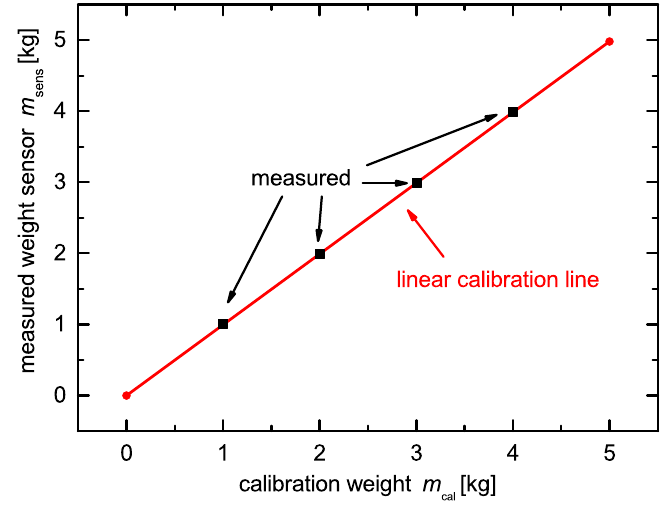
Figure 2. Linear calibration line of the load cell and measured weights using the calibration line. The calibration line is used as a look up table by the Arduino